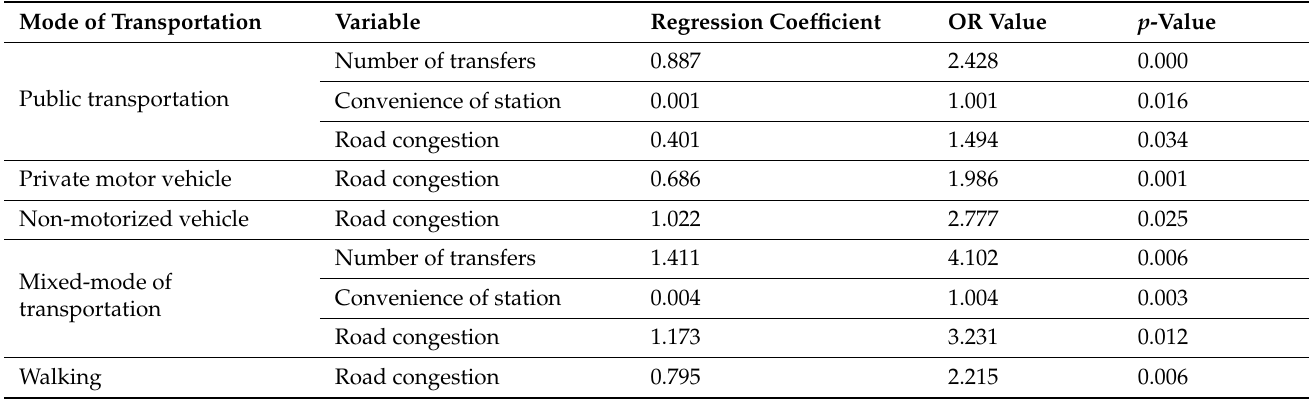
Table 7. Regression analysis on the accessibility evaluation and the elderly’s